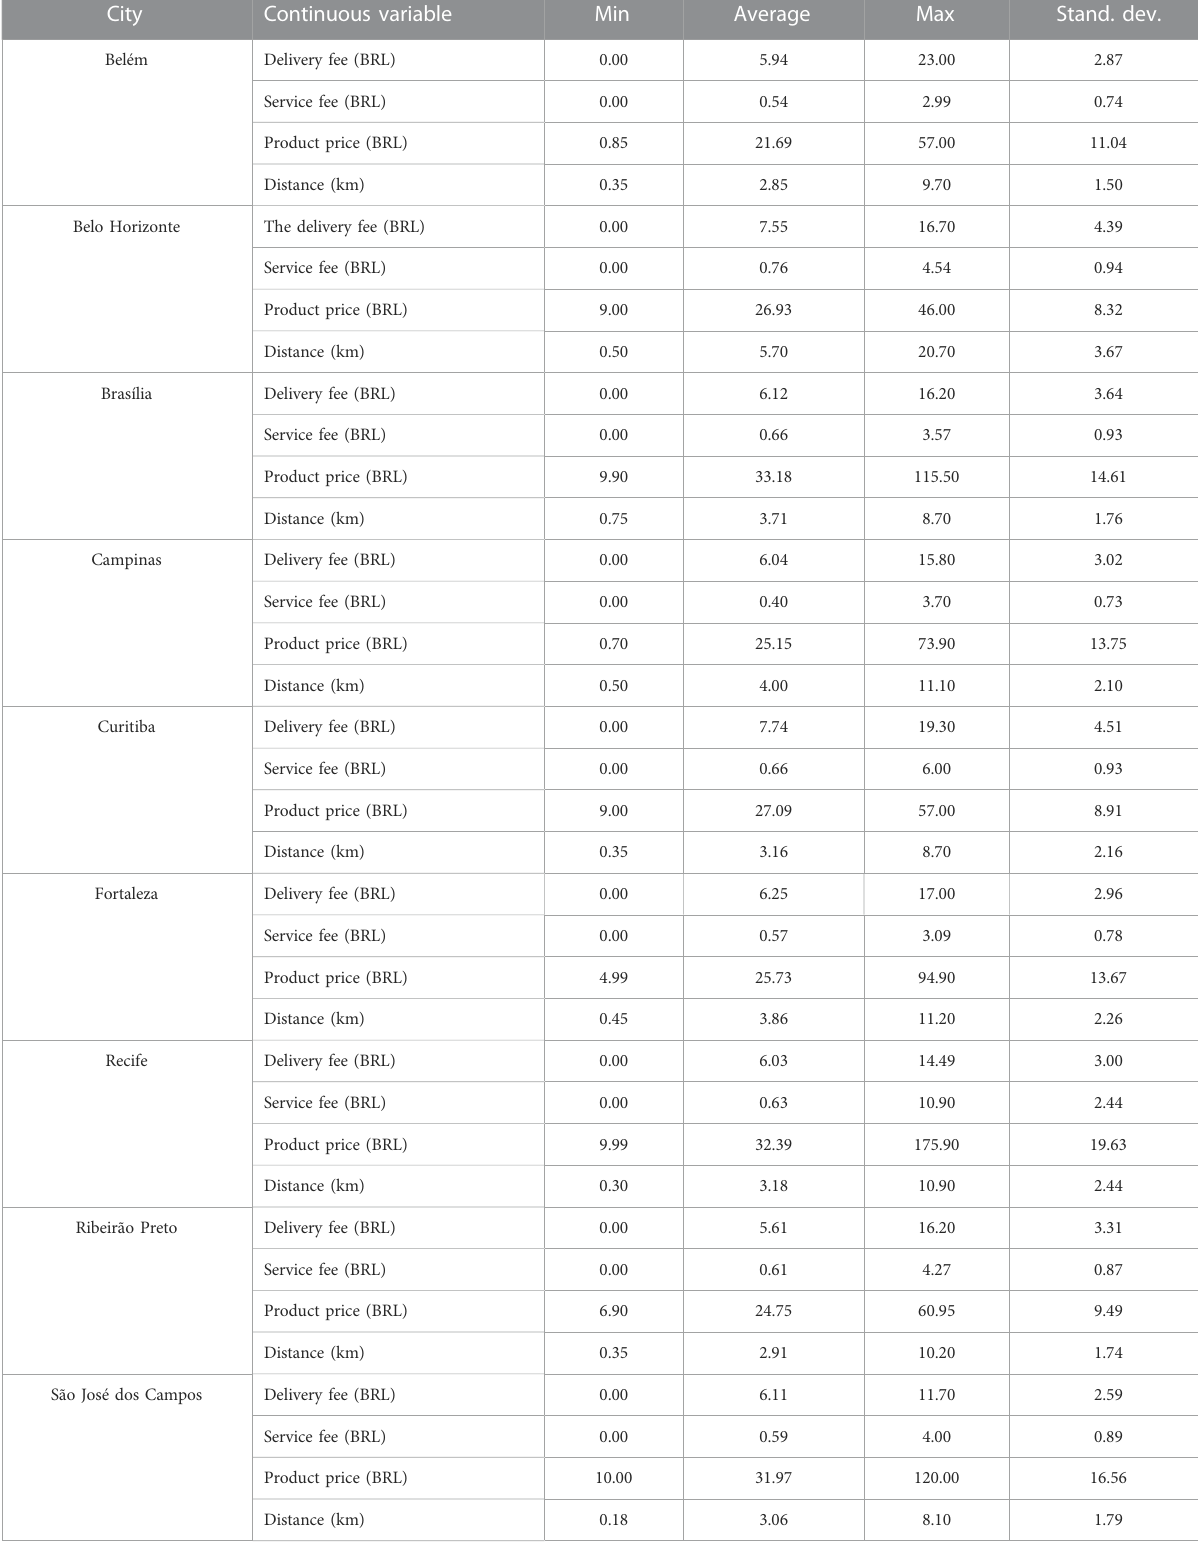
TABLE 1 Description of the continuous